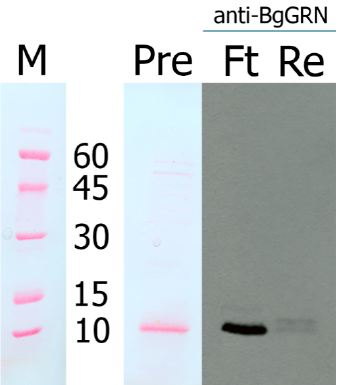
Figure 2. Ponceau stain of pre-column exclusion BgGRN treated with porcine elastase (Pre),